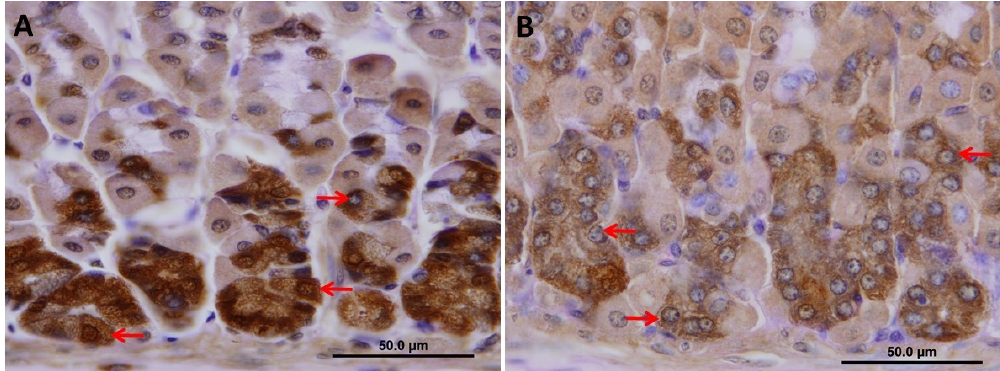
Figure 8. A high magnification micrograph of pepsinogen immunolabeling in tissue sections obtained from the gastric mucosae of control ( A ) and VSL-treated ( B ) mice. Note the reduced pepsinogen labeling in chief cells of VSL mice at the bottom of gastric glands. These cells tend to appear smaller than those of control with a less amount of secretory granules (arrows in A vs. B). Magnification bar = 50 µ